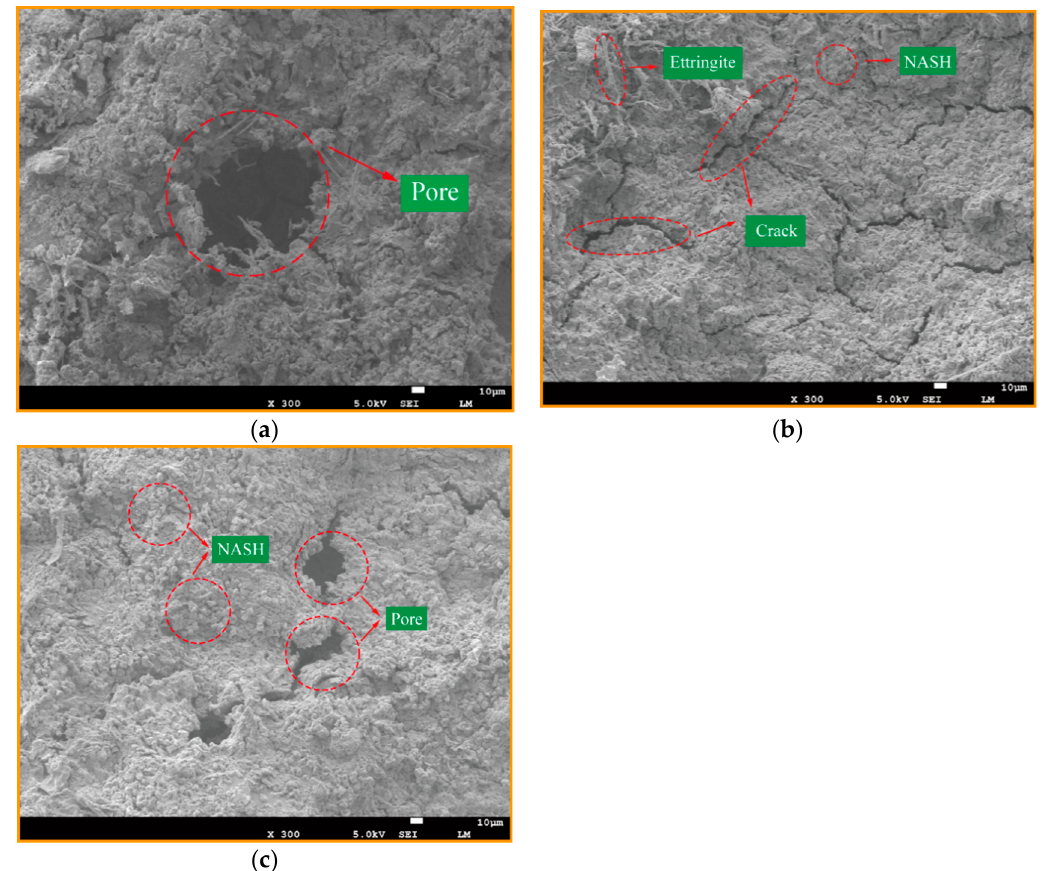
Figure 5. Geopolymer models with different Si/Al molar ratios.